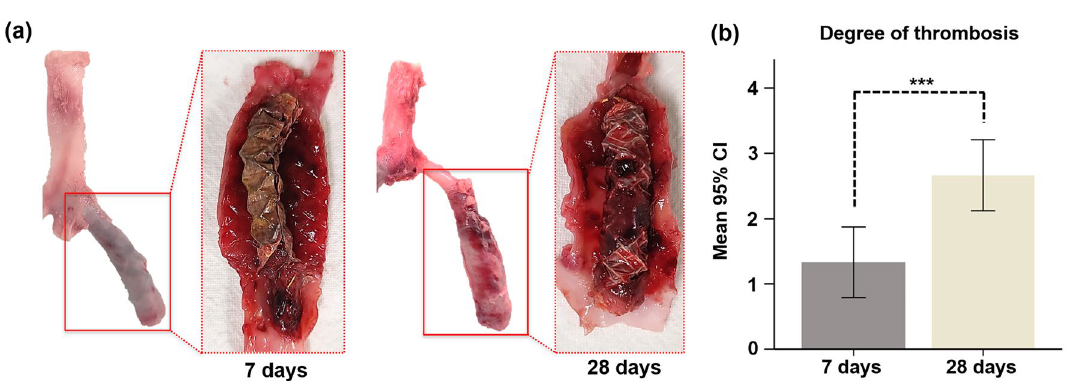
Figure 3. Representative images of gross specimens. ( a ) Image showing TPU and GL blended NFs-covered stent-graft with thrombosis in LIA after sacrifice for extraction at 7 days and 28 days. ( b ) The mean (± SD) degree of the thrombosis at 28 days compared with 7 days. CI, confidence interval; *** p <